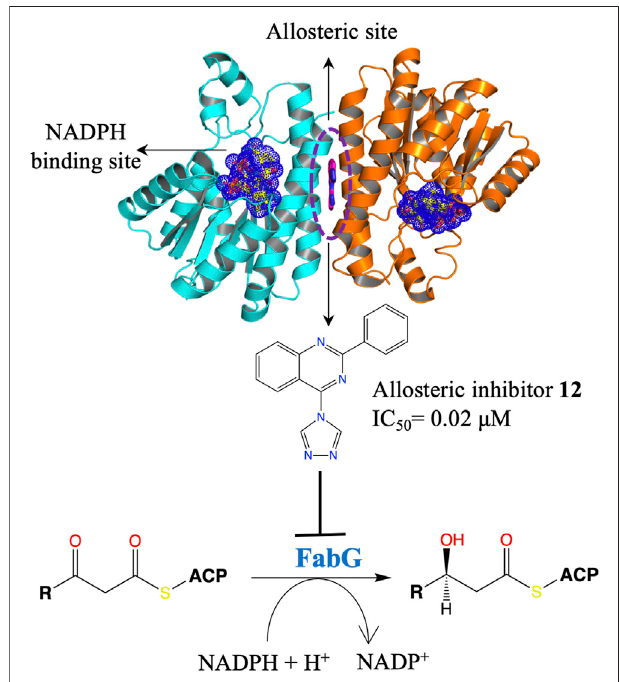
FIGURE 3 | An allosteric inhibitor ( 12 ) of Pa FabG developed by FBDD with an IC 50 of 0.02 μ M. The cosubstrate NADPH from Pa FabG-NADPG complex (pdb id 4ag3) is mapped on the Pa FabG-FG01 complex structure (pdb Id 4bnu) determined by X-ray crystallography (Cukier et al., 2013). The inhibitor binds at the dimer-dimer interface of Pa FabG. Binding of the inhibitor results in disturbance of the binding site of